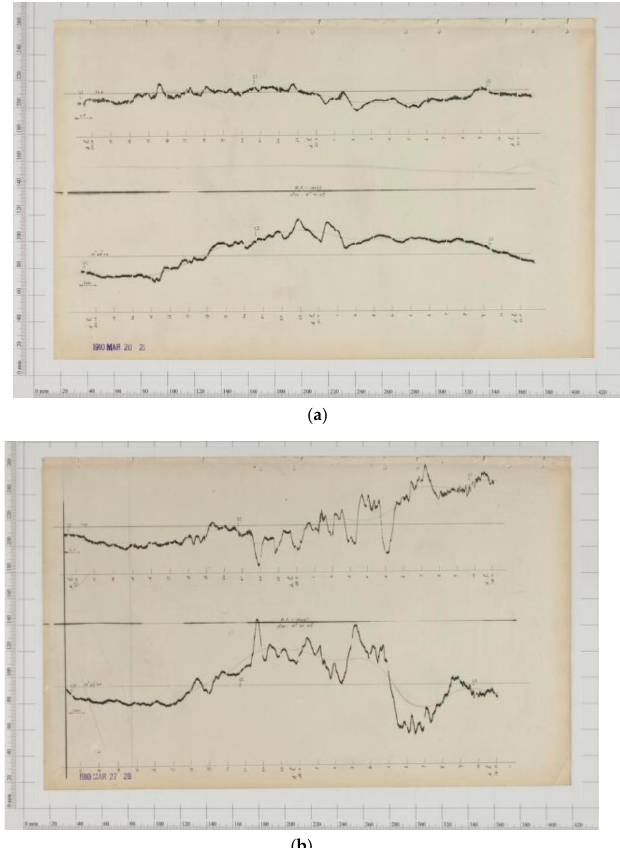
Figure 10. Magnetograms obtained from Greenwich Observatory on 20–21 March 1910 ( a ) and 27–28 March 1910 ( b ), as provided by British Geological Survey (https://webapps.bgs.ac. uk/data/Magnetograms/search.cfc?method=magnetogramSearchbyObservatory, accessed on 27 May 2022). The magnetograms show the H component of the magnetic field and its declination D. The data of panels a, b and c suggest the occurrence of two magnetic storms starting on days 20 and 27 of March 2010, which are associated with the historic heat wave of March. maximum ground air temperatures in March 2012 and March 2010 in two large cities in NE ‐ USA: Madison, Wisconsin (panel a and c), and Detroit, Michigan (panels b and d). A comparative inspection of the time series on the left and the right side of Figure 9 makes it clear that the temperature records remained at very high levels for a longer time in March 2012 than in March 1910. For instance, we note that the temperature in Madison achieved levels T M > ≈ 25.5 °C (78 °F) for 3 days (23, 27 and 29) in March. Figure 9, in panels c and d show that the magnetic storm S1 proceeds the starting time (normal green dashed line) of M1910HW. A large magnetic storm is always due to a solar structure, which is characterized by a SEP event starting at least about 2 days before the magnetic storm; this is shown by the normal black lines in panels a and b, which in ‐ dicate the onset time of March 2012 SEPI event. We can reasonably hypothesize that a SEP event occurred in March 1910 at almost the time indicated by the dashed normal black line.